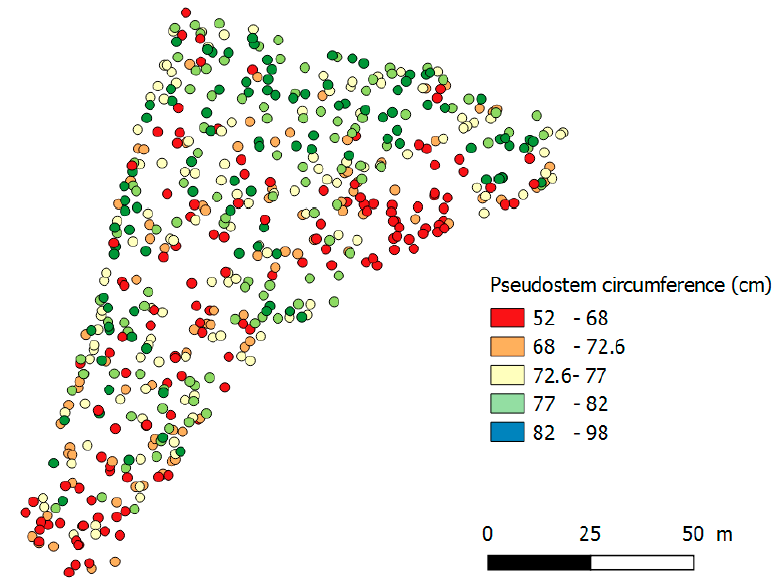
Figure 5. Spatial measurements of pseudostem circumference divided in 5 quantiles within the plot under study.